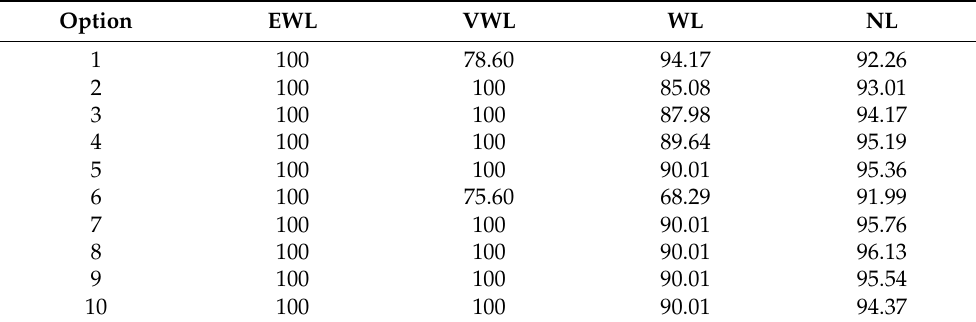
Table 7. Baseline B ambiguity-fixed rate for different linear combinations based